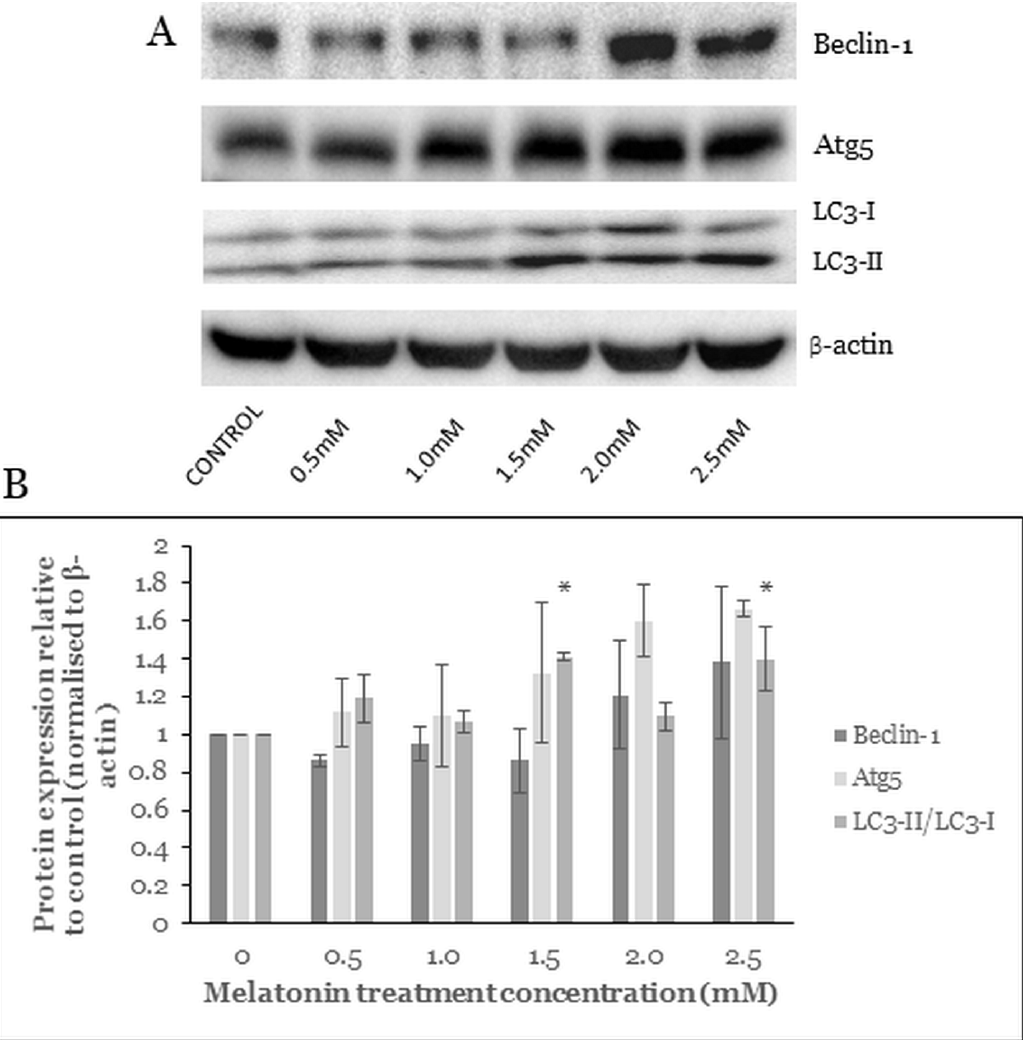
Figure 7. Western blot analysis of the melatonin-treated HT-29 cells. Effects of melatonin on autophagy pathway protein expressions in HT-29 cells after treated with various concentrations of melatonin for 72 h. ( A ) Expression levels of autophagy proteins were assessed by western blot analysis. ( B ) Bar chart of proteins expression; each bar represents a mean ± SEM of three independent experiments. One-way ANOVA was performed to compare each treatment group with control; statistically significantly different from control: *, p < 0.05.